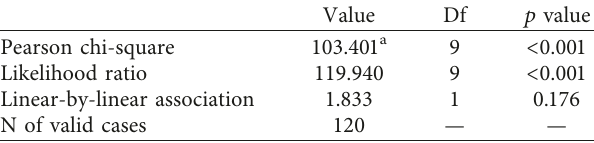
Table 5: Chi-square tests for comparisons of ARI values in different